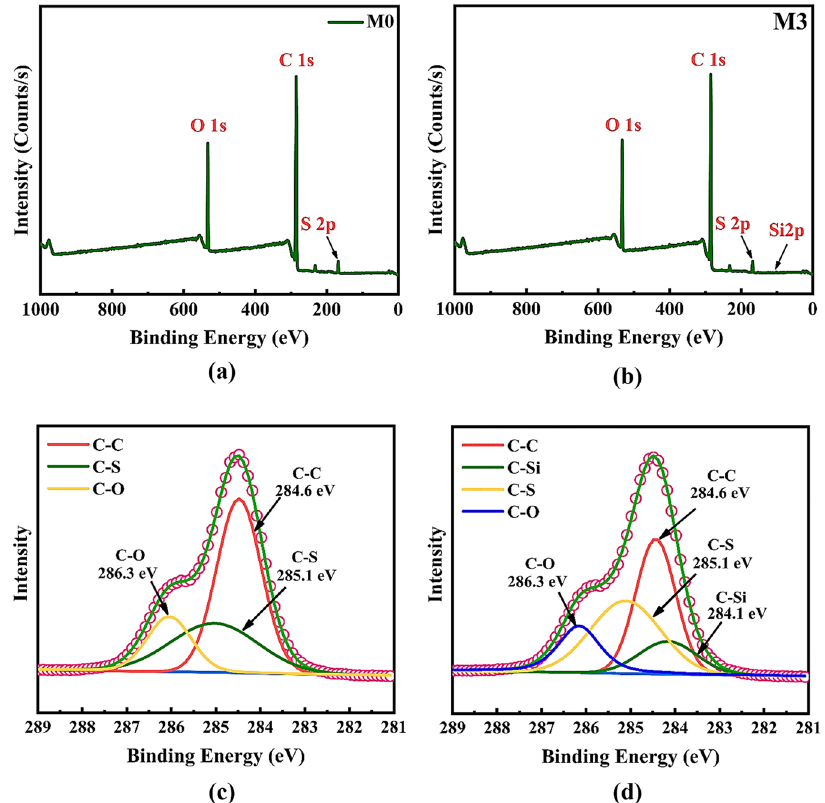
Fig. 3 Surface characterizations. XPS survey spectra for M0 ( a ) and M3 ( b ) and deconvoluted peaks for M0 ( c ) and M3 ( d